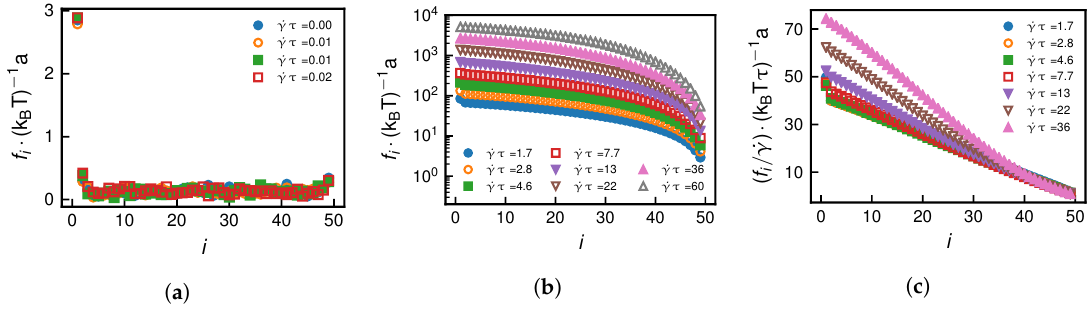
Figure 8. Grafted scenario: Tensile force profiles ( N = 50 ) for shear rates ( a ) far below and ( b ) far above the critical shear rate ˙ γ ∗ = 0.168 τ − 1 . In subfigure ( c ), we demonstrate the strong-stretching scaling collapse f i ∼ ˙ γ predicted by Sing and Alexander-Katz [39]. Deviations from the scaling collapse coincide with a strong increase in mean radius of gyration shown in Figure 2a and are due to the extensible chain model.